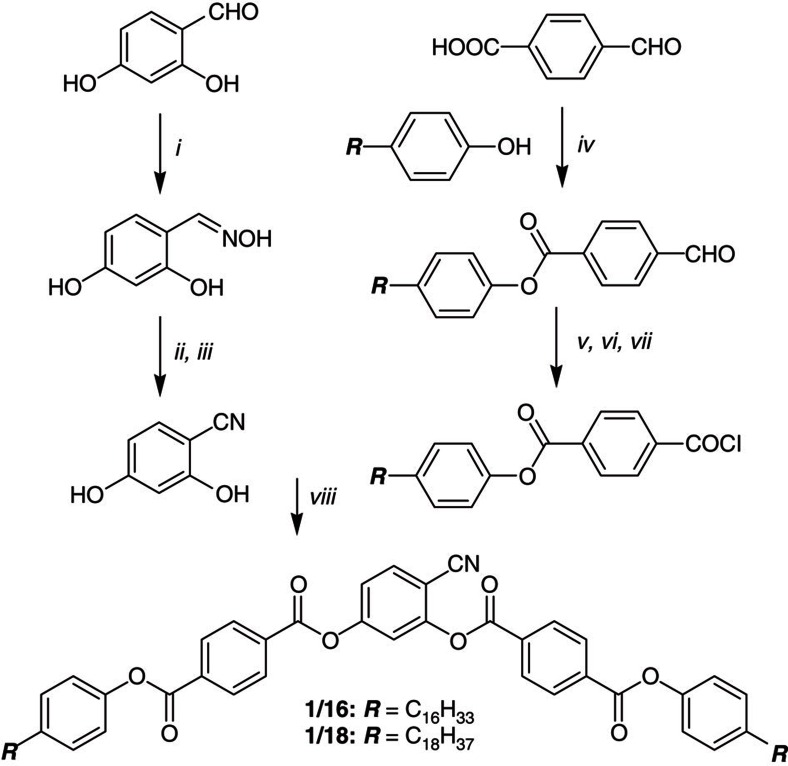
Synthesis of compounds 1/n.Reagents and conditions: (i) NH2OH·HCl, EtOH, Na2CO3, 20 °C, 6 h; (ii) Ac2O, reflux, 3 h; (iii) KOH, H2O, 20 °C, 72 h; (iv) DCC, DMAP, CH2Cl2, 20 °C, 24 h; (v) NaClO2, NaH2PO2, resorcinol; t-BuOH, 20 °C, 12 h; (vi) HCl, H2O, 20 °C, 20 min; (vii) SOCl2, DMF, reflux, 1 h; (viii) Et3N, cat. pyridine, CH2Cl2, reflux, 6 h.